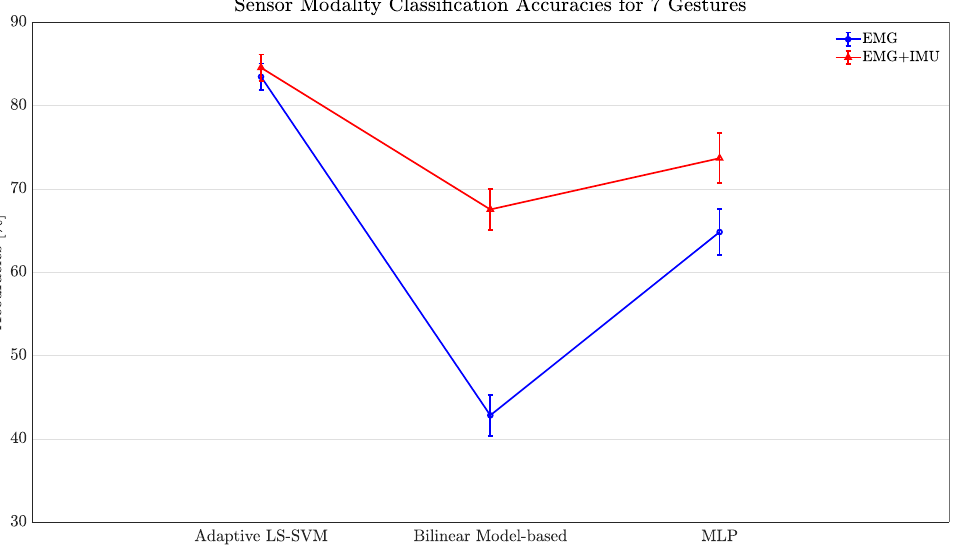
Figure 13. Overall accuracies of the classification methods using EMG data, and EMG and IMU data. Error bars represent the standard error of the